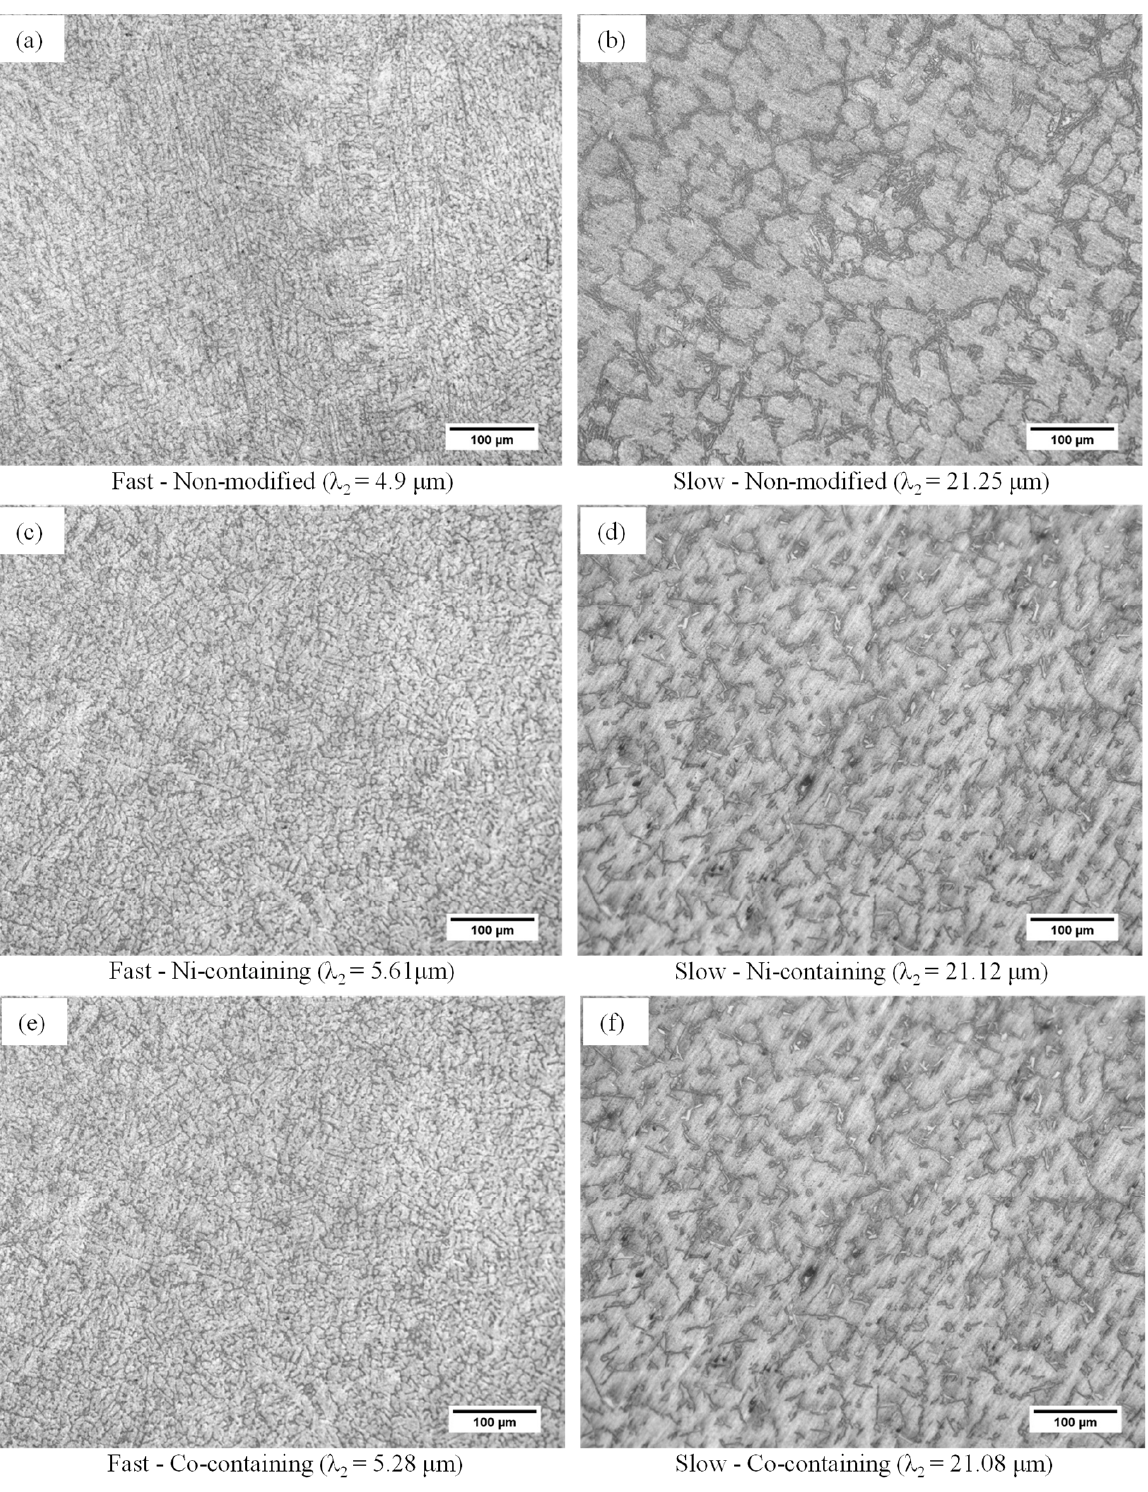
Figure 2. Optical micrographs related to the Al-Si-Fe-Cu-Zn (-Co, -Ni) alloys processed under fast ( a , c , e ) and slow ( b , d , f ) cooling conditions.